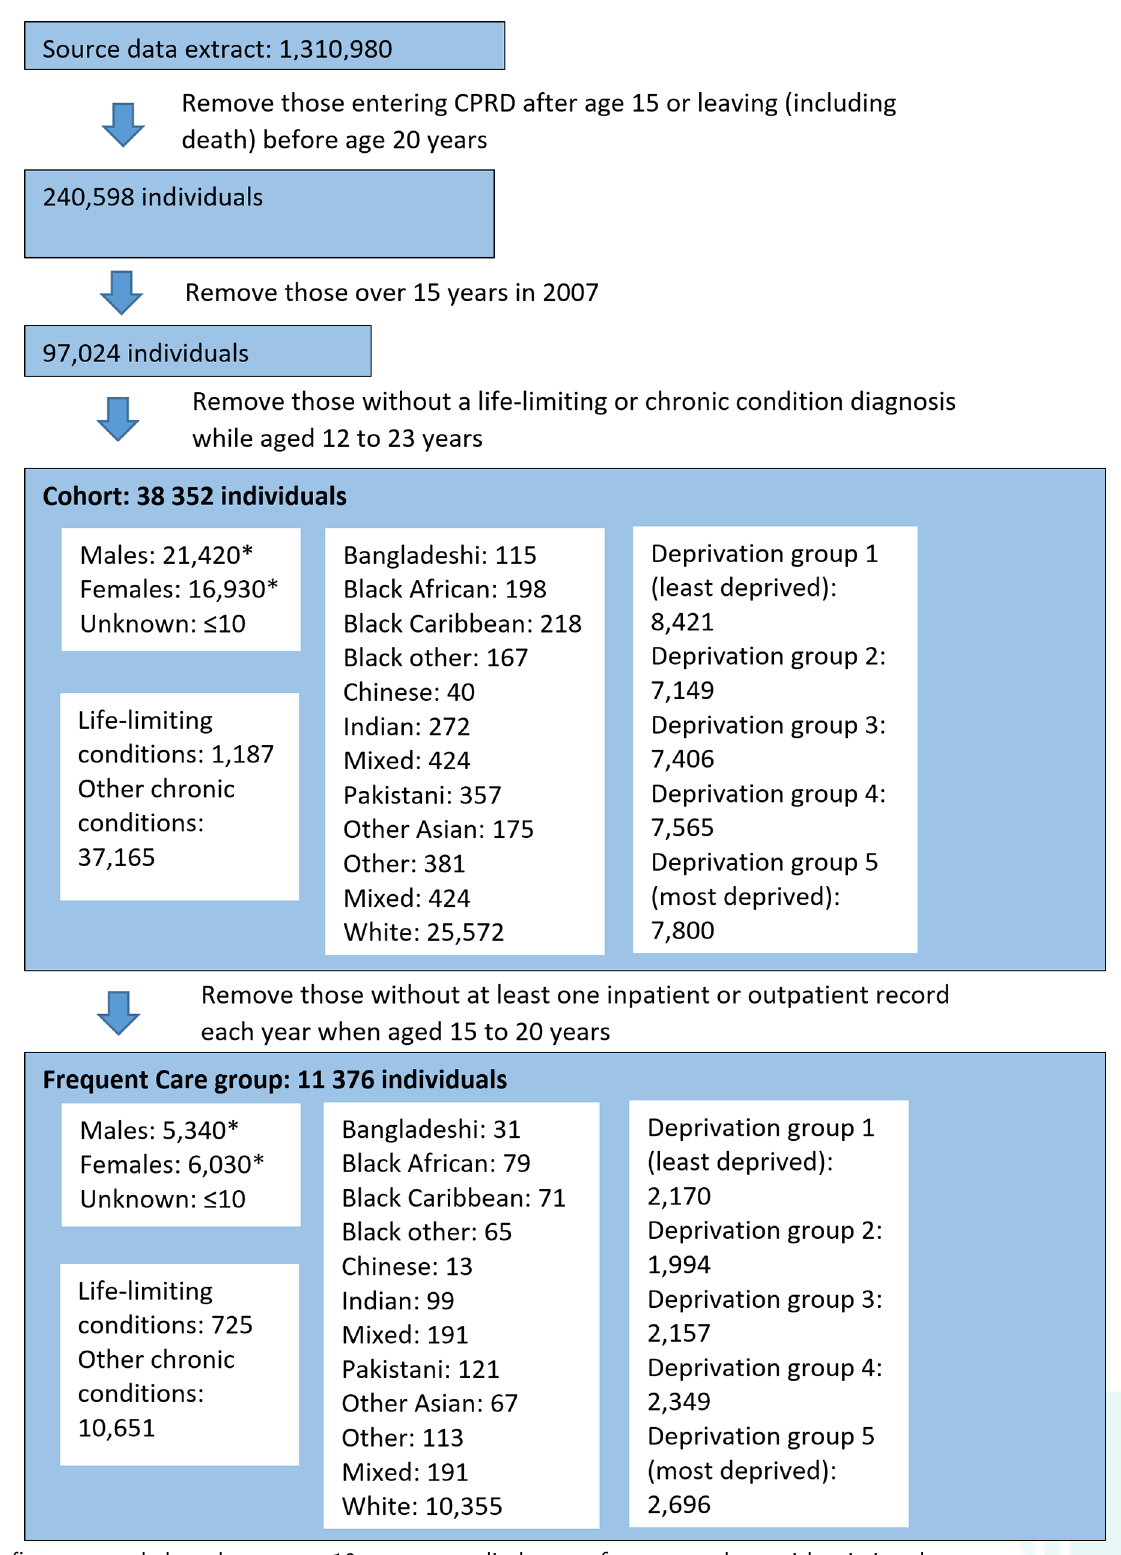
Figure 3: Cohort construction flow diagram showing inclusion criteria and data sources, with final sizes of cohort, Frequent Care group and the demographics in those